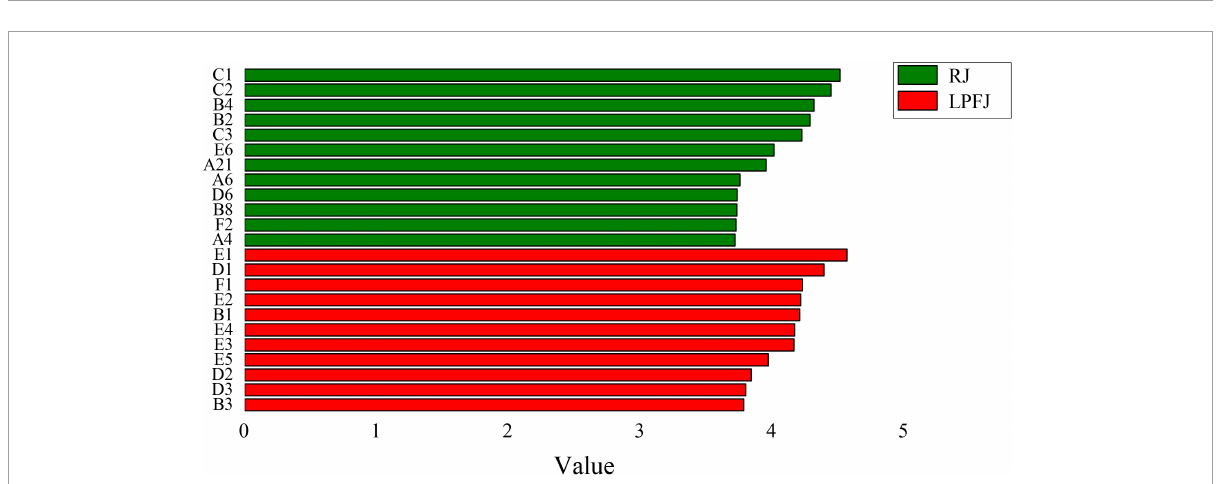
FIGURE3 Linear discrimination analysis and the Kruskal-walls test to find significantly different aroma species (LDA score). A volatile compound with an LDA score > 3.7 was considered a significantly different species and a biomarker of soymilk fermentation. RJ, raw juice; LPFJ, L. plantarum fermented